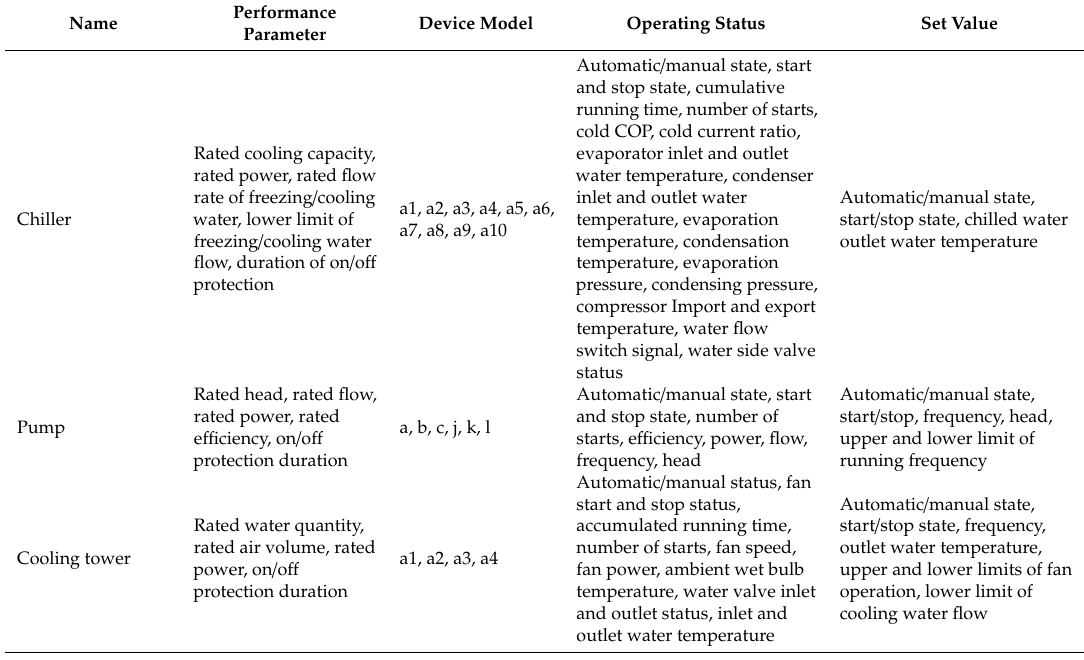
Table 1. Standard information points of the smart